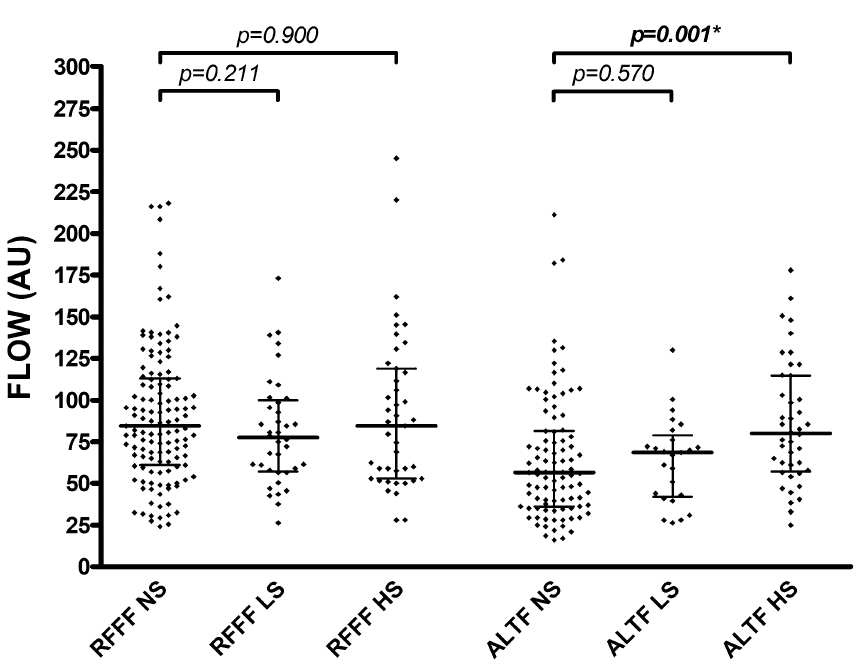
Figure 1. Intraoperative perfusion measurement. Each dot represents an individual blood flow (AU) with median (center line) and 1. and 3. quartile (upper and lower lines) for intraoperative measurement (separately described for the group of nonsmokers (NS), the group of light smokers (LS) and the group of heavy smokers (HS)); p values corresponding to testing for differences with Mann Whitney test; significant p values are bold (* p = 0.006 with adjustment for sex, age, BMI, diabetes, mean arterial pressure and catecholamine dose); RFFF radial free forearm flap, ALTF anterolateral thigh flap, NS nonsmokers, LS light smokers, HS heavy smokers, AU arbitrary